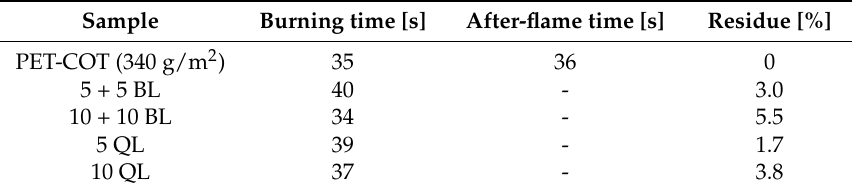
Table 18. Combustion data of untreated and LbL-treated PET-COT fabrics by vertical flame spread tests [31].